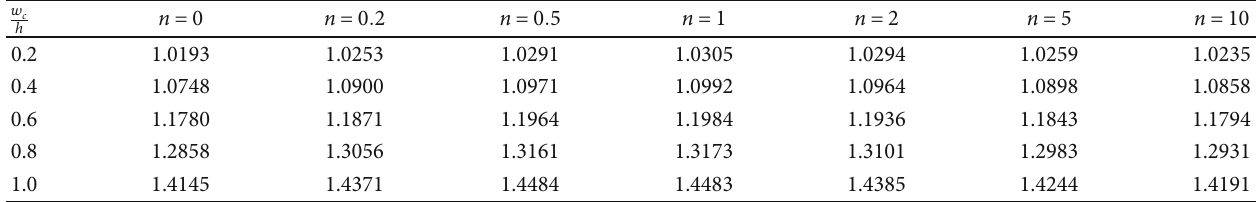
ω NL / L of 2D-FGM square plate,